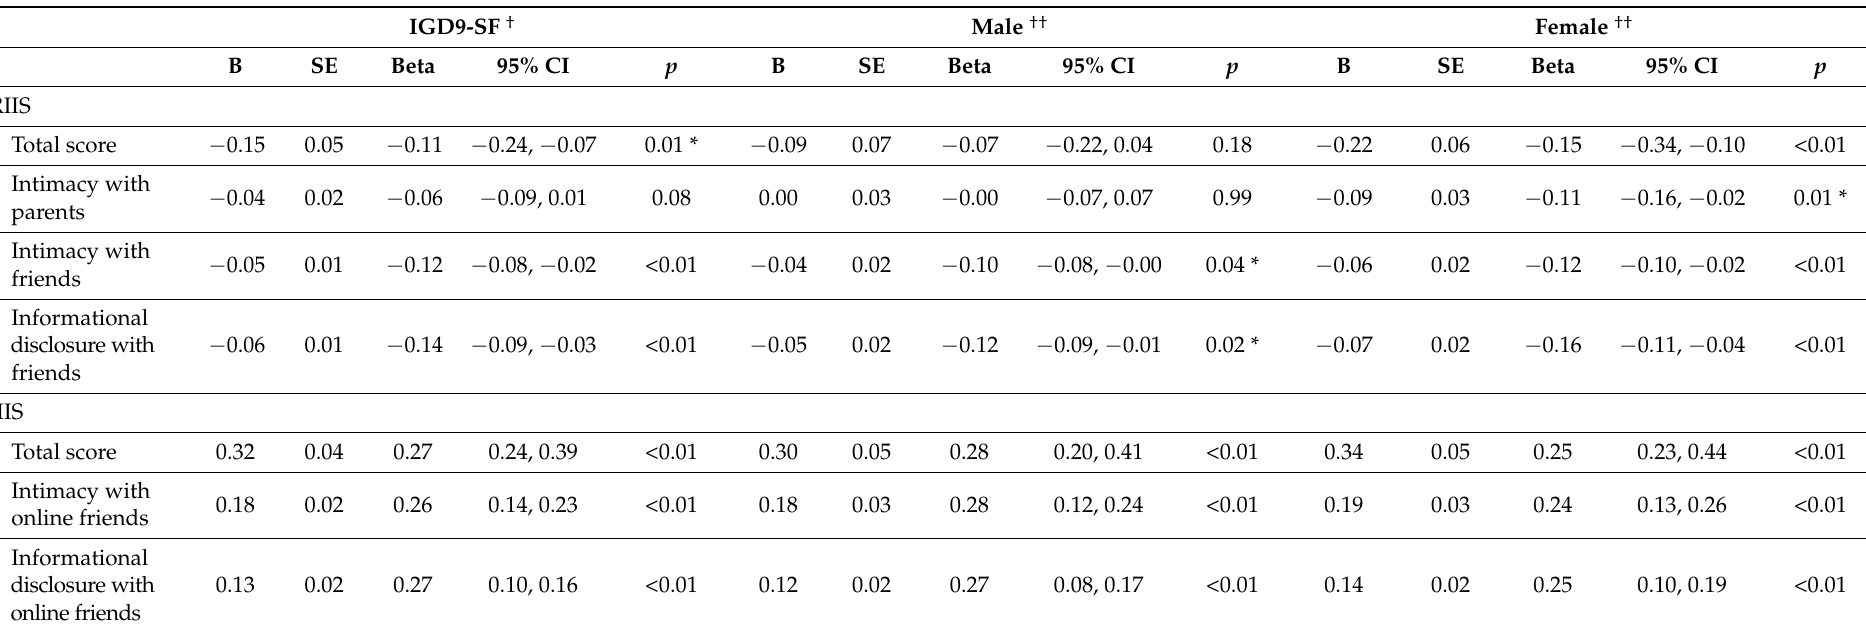
Table 5. Multiple regression analysis for identifying Real Interpersonal Interaction Scale (RIIS)/Internet Interpersonal Interaction Scale (IIIS) with their dimensions significantly related to Internet Gaming Disorder Scale